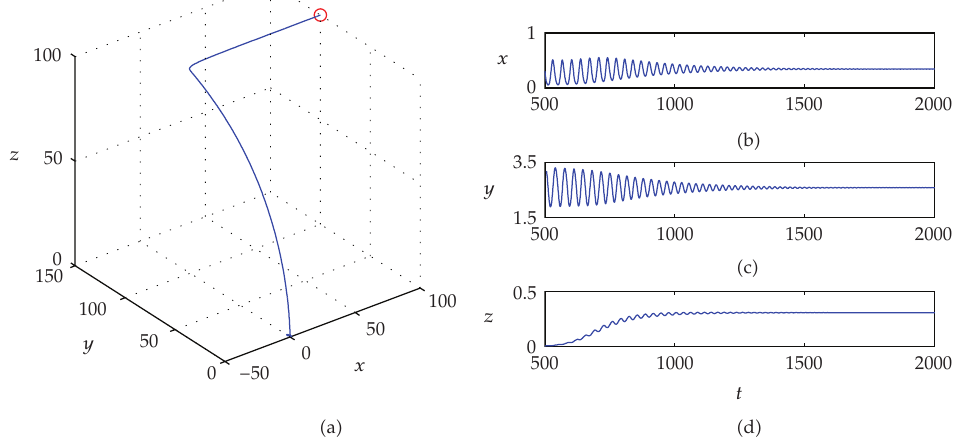
Figure 2: a (cid:7) 1 . 5, b (cid:7) 1, c 1 (cid:7) 0 . 6, c 2 (cid:7) 0 . 6, c 3 (cid:7) 0 . 7, c 4 (cid:7) 0 . 7, d 1 (cid:7) 0 . 1, d 2 (cid:7) 0 . 45, α 1 (cid:7) 1, α 2 (cid:7) 1 . 1, and β (cid:7) 1 . 1 and an initial condition (cid:3) 100 , 100 , 100 (cid:6) . (cid:3) a (cid:6) The trajectory of system (cid:3) 1.2 (cid:6) . (cid:3) b (cid:6) – (cid:3) d (cid:6) Time series for x (cid:3) t (cid:6) ,y (cid:3) t (cid:6) , and z (cid:3) t (cid:6)